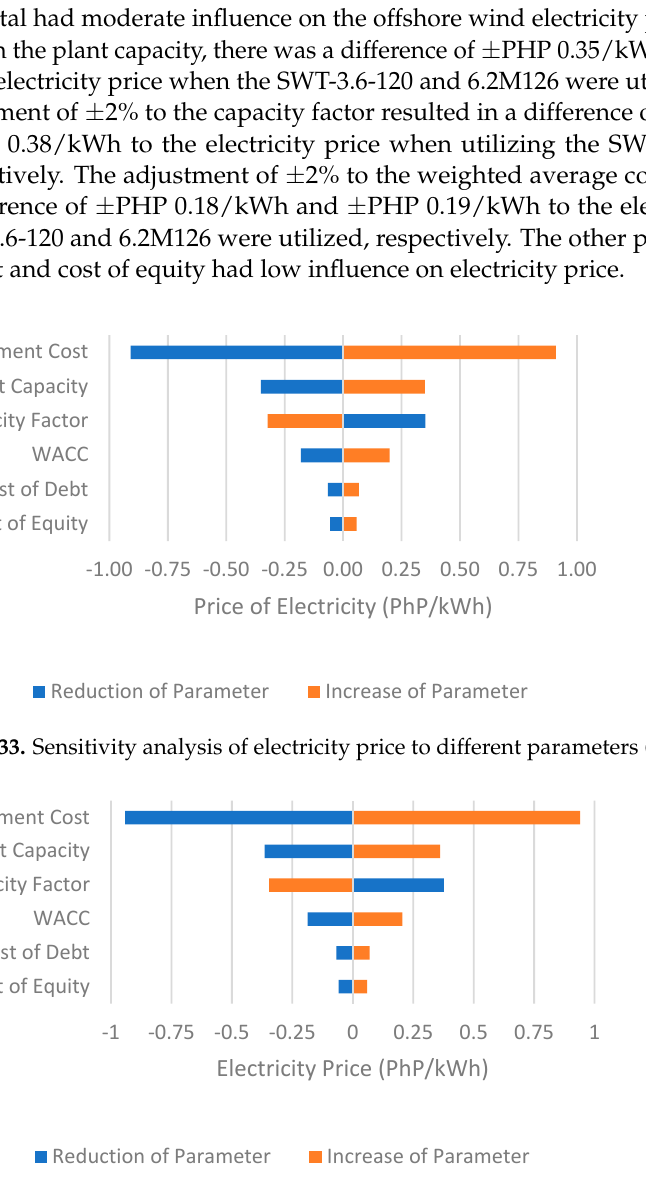
Figure 34. Sensitivity analysis of electricity price to different parameters (6.2M126).